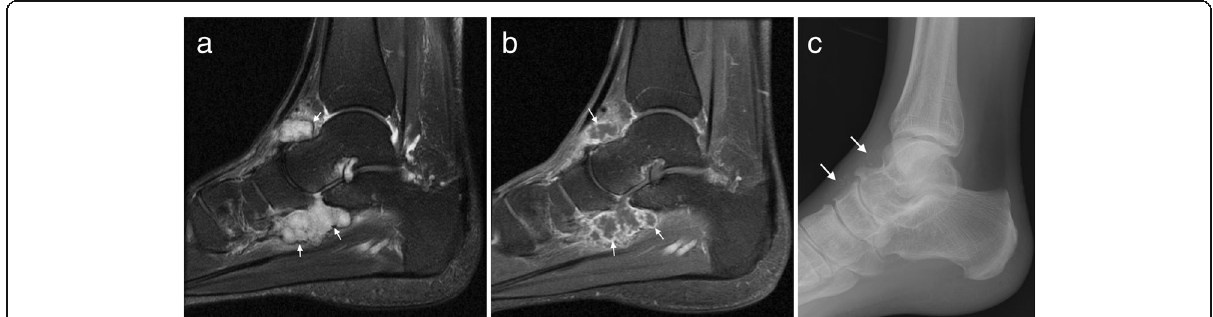
Fig. 9 Synovial chondromatosis. a Sagittal T2FS image of the ankle demonstrating a lobulated T2 hyperintense lesion with a low signal rim (arrows) and b avid synovial enhancement on post contrast T1FS imaging (arrows). c Mineralisation is better appreciated on the corresponding radiograph (arrows).